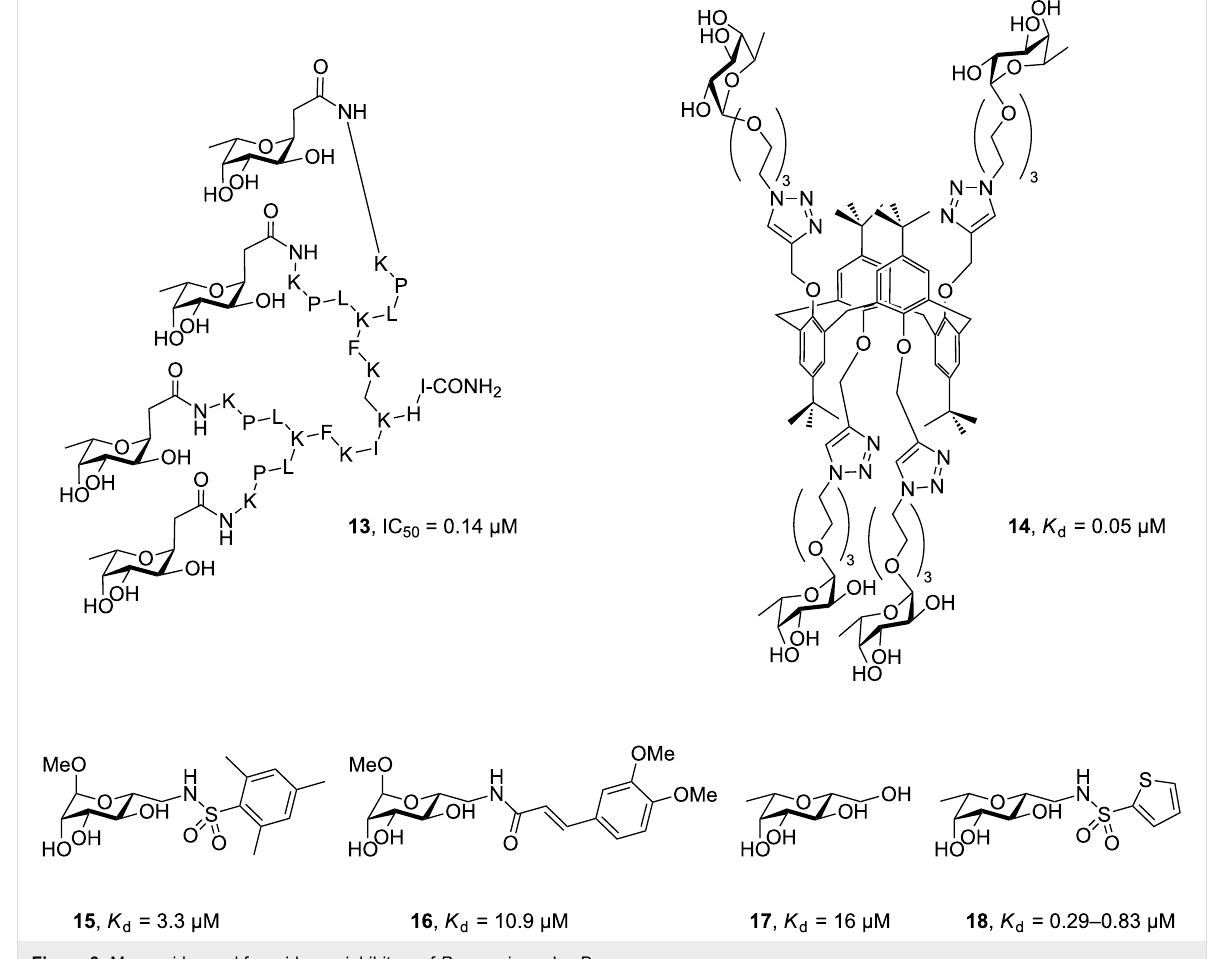
Figure 3: Mannosides and fucosides as inhibitors of P. aeruginosa LecB.